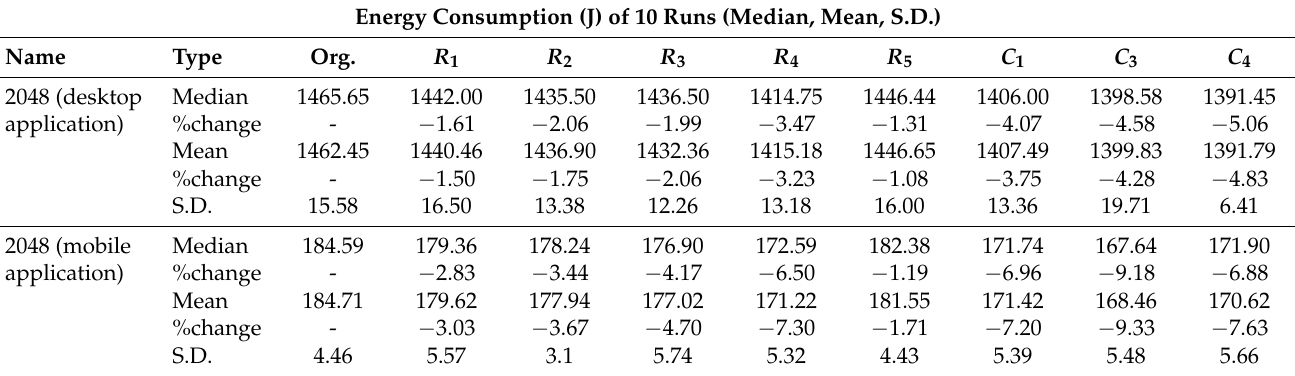
Table 8. Results of energy consumption. All experiments were carried out at same time interval (300 s). Energy Consumption (J) of 10 Runs (Median, Mean,